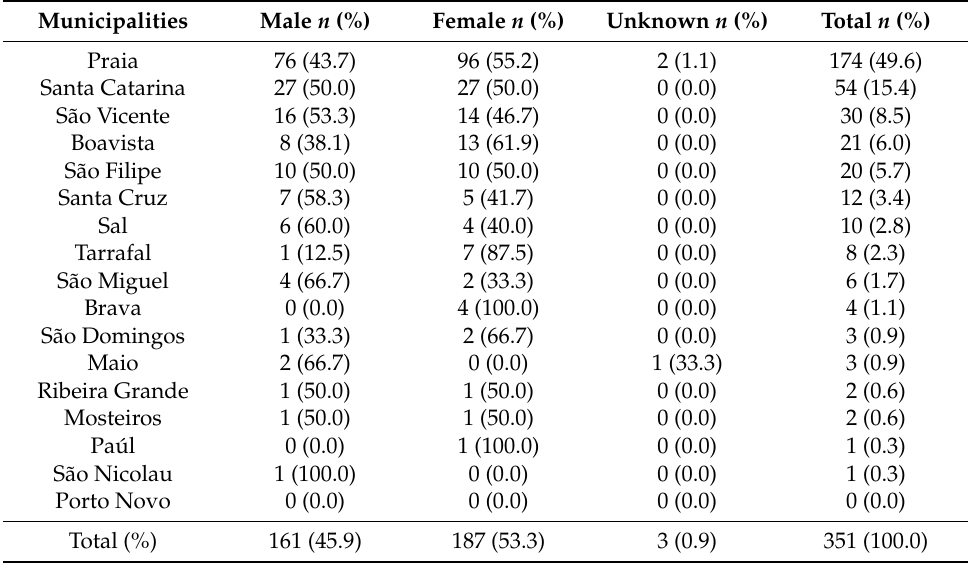
Table 1. New cases of HIV infection diagnosed in Cape Verde, by Health delegacy, 2012.